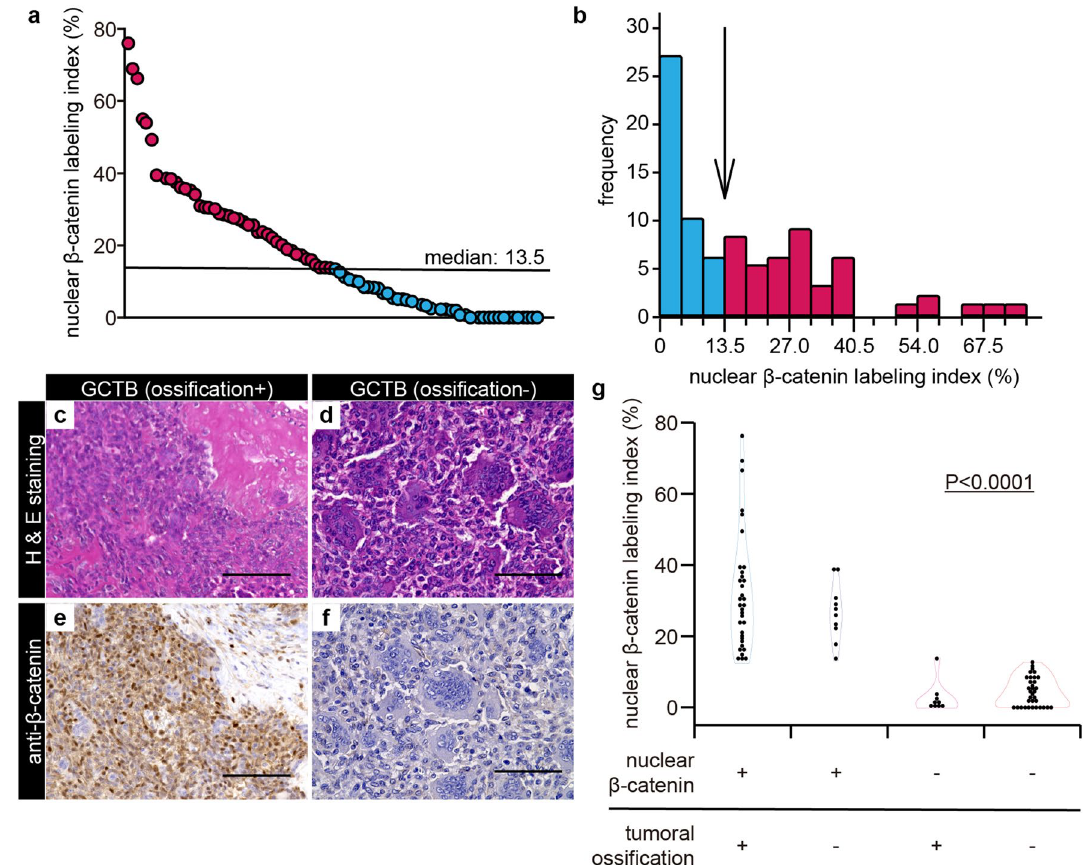
Figure 5. Nuclear β-catenin translocation in GCTB-SCs was significantly associated with endogenous ossification of GCTB. ( a ) Eighty-six clinical GCTB samples were retrospectively reviewed, and the nuclear β-catenin labeling index (NBLI) in the GCTB-SCs was calculated. Three to five hotspots per high-power field were evaluated, depending on the level of nuclear β-catenin expression. The median value (13.5) was set as a cut-off for NBLI. ( b ) Histogram showing non-normal distribution of NBLI in the GCTB-SCs. The image is color-coded according to the median value of NBLI (arrow). ( c – f ) Representative images of GCTB specimens with or without intra-tumoral ossification and the results of immunohistochemistry for β-catenin. A typical massive intra-tumoral ossification with focal tumor region was strongly positive for nuclear β-catenin in the stromal component with the ossified case, whereas osteoclastic giant cells were negative for that ( c , e ). The stromal components surrounding the remaining giant cells were negative for β-catenin in the non-ossified case ( d , f ). Scale bar, 100 μm. ( g ) Violin plots of NBLI of GCTB-SCs depicting the association between the nuclear translocation of β-catenin with intra-tumoral ossification of GCTB. The nuclear β-catenin–positive group exhibited a significantly higher intra-tumoral ossification rate than the negative group (P < 0.001, Fisher’s exact